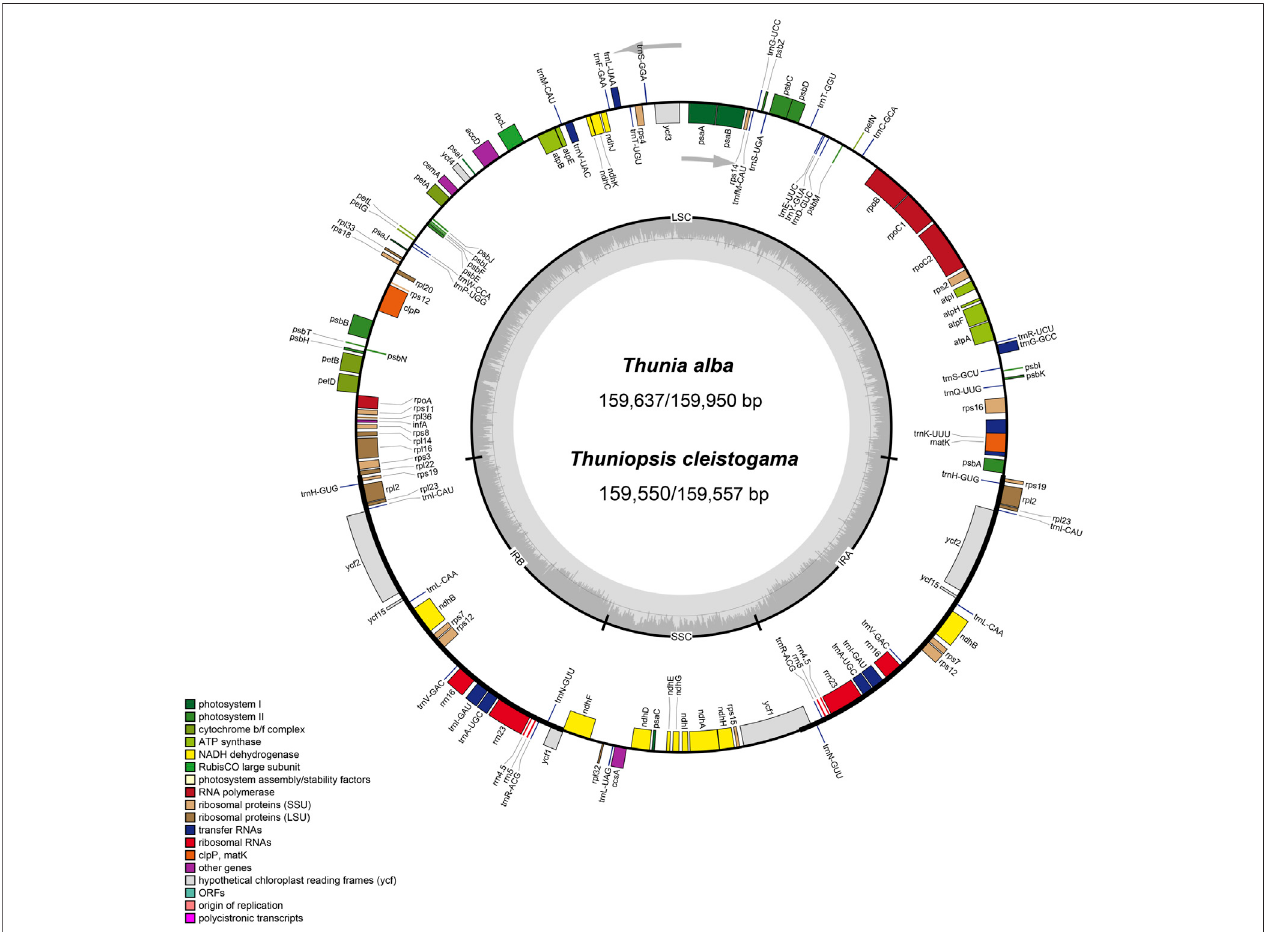
FIGURE 1 | Circular gene map of chloroplast genomes from Thuniopsis cleistogama and Thunia alba . Genes inside and outside of the circle are transcribed in clockwise and counterclockwise directions, represented with arrows. Bars of different colors indicate different functional groups. LSC, large single copy region; IR, inverted repeats (IRa and IRb); SSC, small single copy